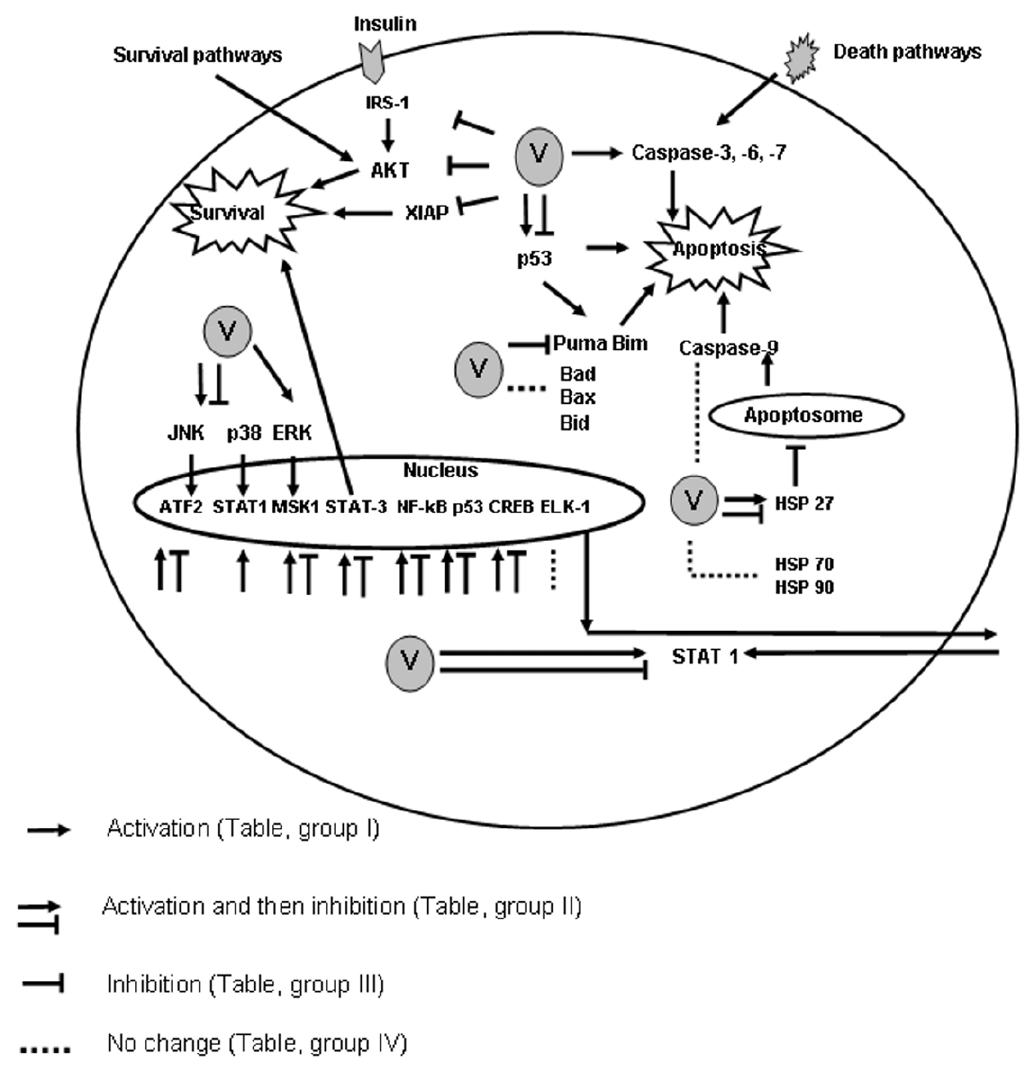
Figure 8. RPMA data presented as a diagram of signaling events in HSAECs infected with RVFV. Among the most prominent responses was activation of MAP kinases (p38, JNK and ERK) and the downstream transcriptional factors [STAT1 (Y701), ATF2 (T69–71), MSK1 (S360), and CREB (S133)]. STAT3 and NF- k B phosphorylation were also increased. Activation of p53(S15, S46), which typically accompanies transcriptional upregulation of the apoptotic genes correlated with the increased levels of cleaved effector caspase-3, -6 and -7 indicating activation of the extrinsic apoptotic pathway. RVFV infection also downregulated phosphorylation of a major anti-apoptotic regulator of survival pathways, AKT (S473). Consistent with this, the level of apoptosis inhibitor XIAP100 was decreased. The intrinsic apoptotic pathway marker, caspase-9, demonstrated only a marginal activation accompanied by increased level of the inhibitor of apoptosome formation, HSP27.